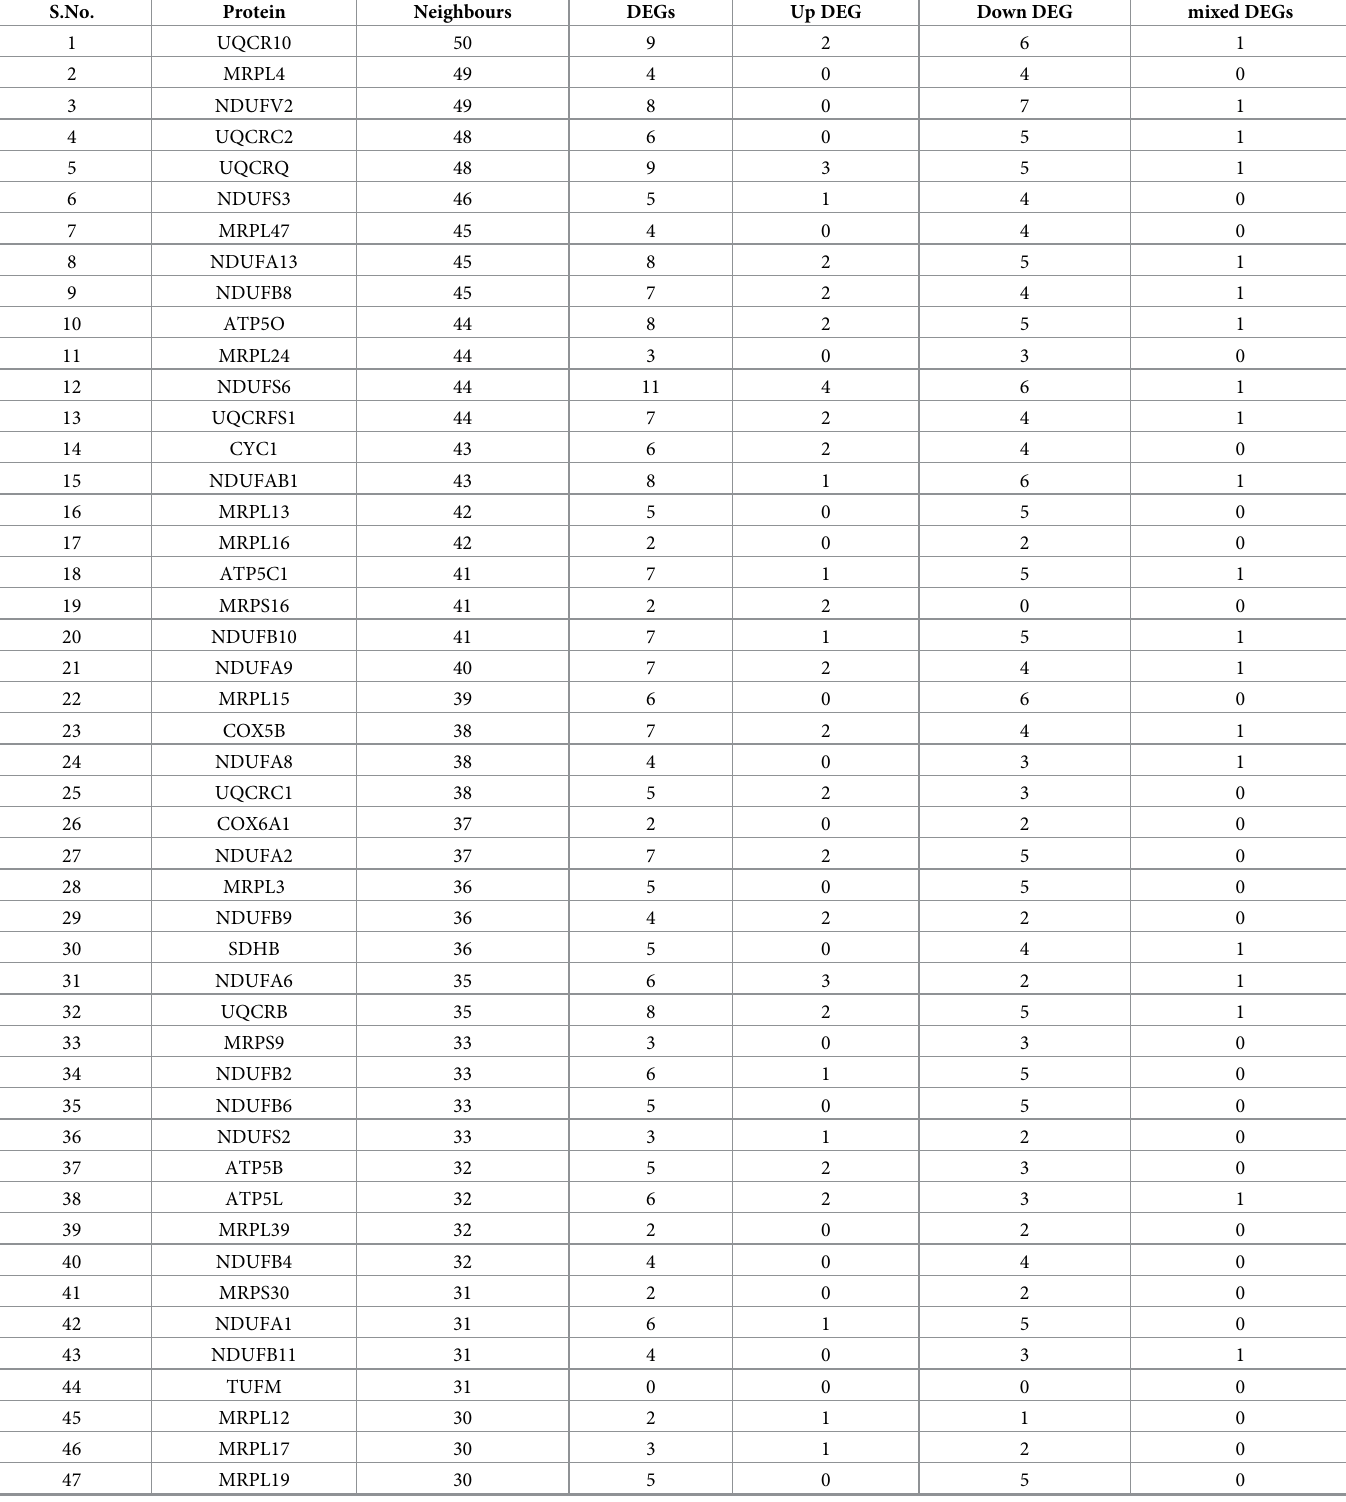
Table 4. Number of neighbours for the top 50 mitochondrial PPI network hub proteins.